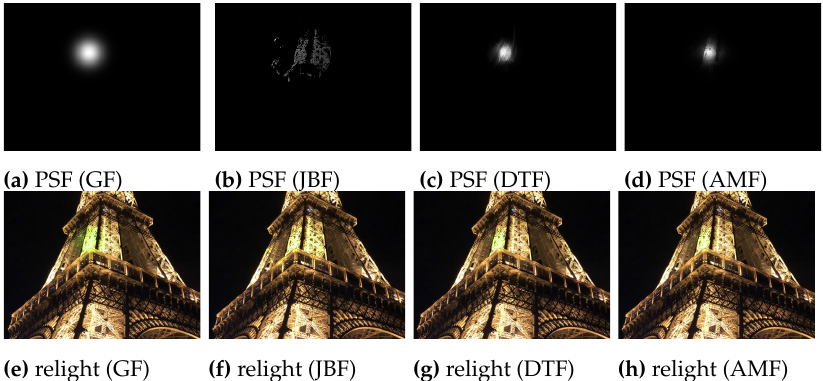
Figure 13. Comparison of 4 omnidirectional diffusion methods. ( Top ) PSFs; ( Bottom ) the output image with